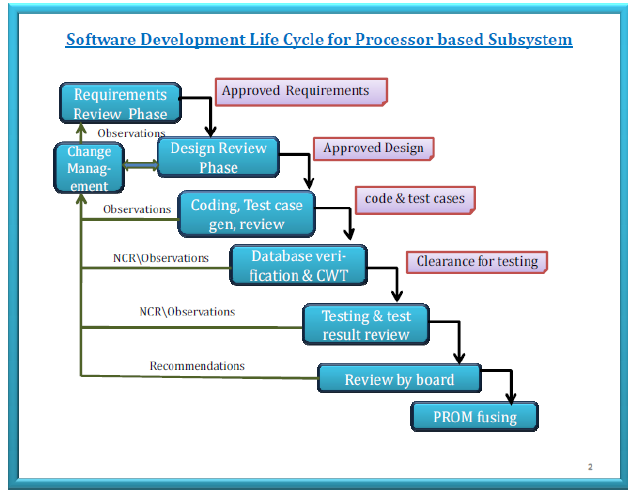
Figure 2. Development, Verification and validation within IEEE 12207